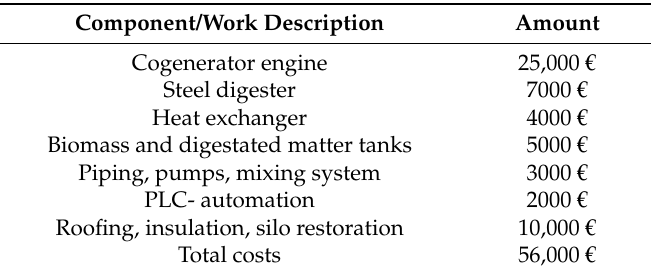
Table 3. CAPEX for ERS